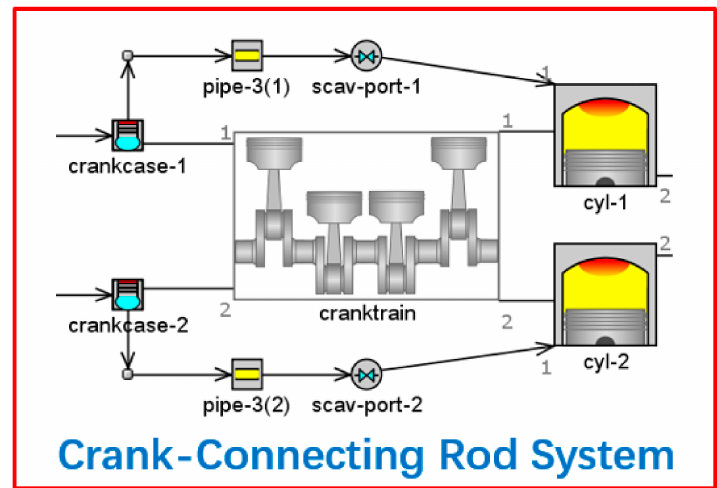
Figure 13. The layout of crank-connecting rod system in